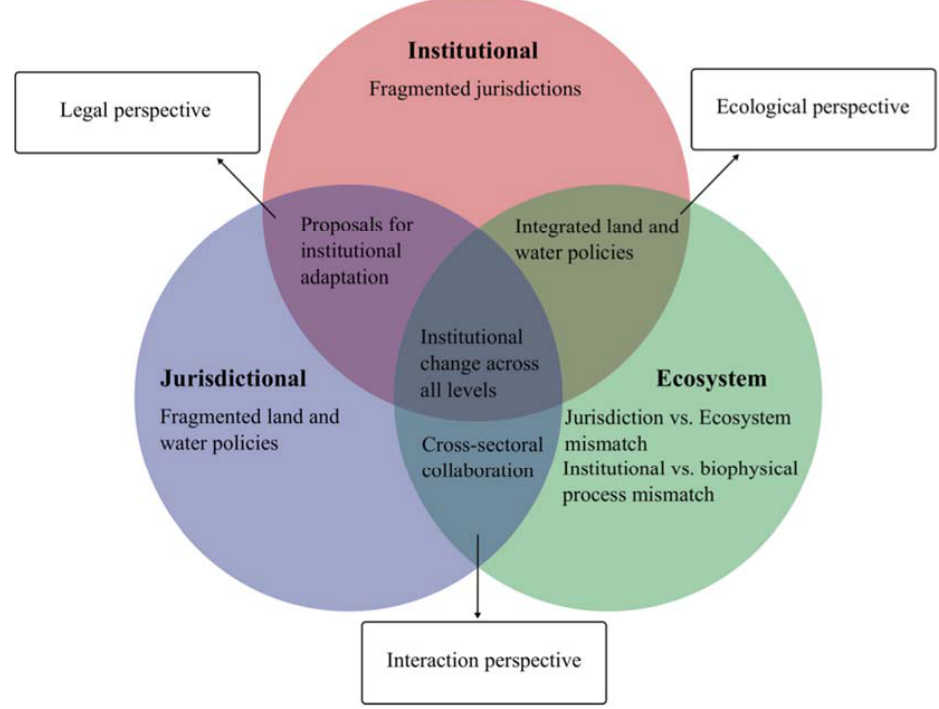
Figure 4. Mismatches across three different scales and perspectives, with the main barriers for each scale mismatch and overlapping areas that indicate the perspectives to match between two or (in the centre) all three scales.